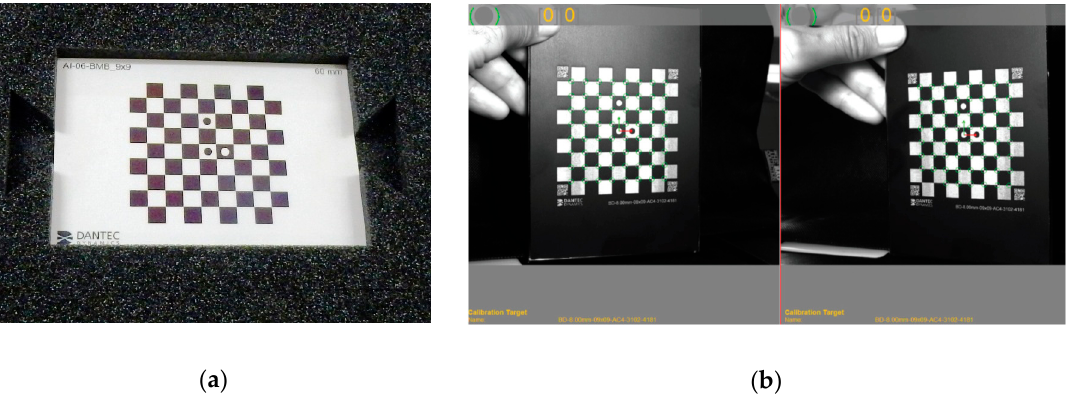
Figure 4. 3D-DIC system- Calibration: ( a ) The example of a calibration target; ( b ) Calibration live image [8].